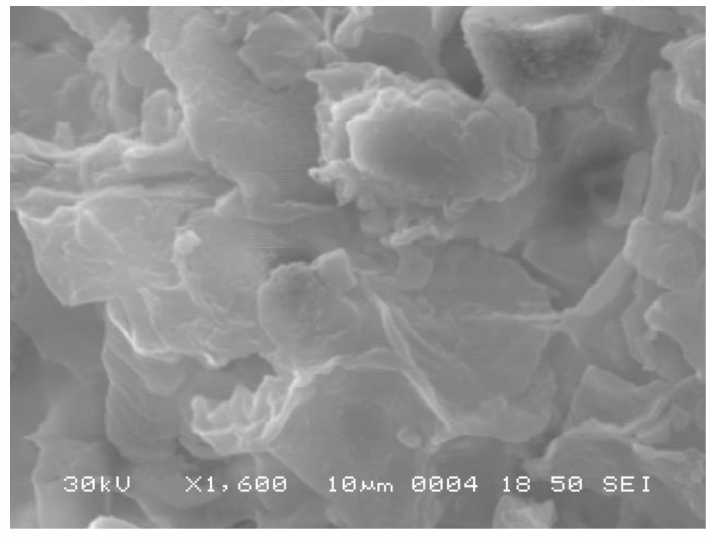
Figure 4. SEM images of Nerium oleander fruit.